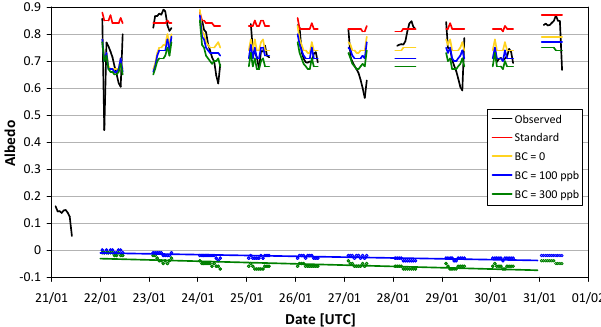
Figure 5. Comparison of observed (black) and simulated albedo at NCO-P for the period 22 to 31 January 2005. Model results are obtained with the upgraded model including radiative trans- fer with different BC concentrations: 0 (yellow), 100ppb (blue), and 300ppb (green). Circles at the bottom indicate the differences of the simulated albedo between BC = 100ppb and 0 (blue) and BC = 300ppb and 0 (green). Straight blue and green lines show the results obtained by linear regressions for the albedo differences dur- ing the period 22 to 30 January